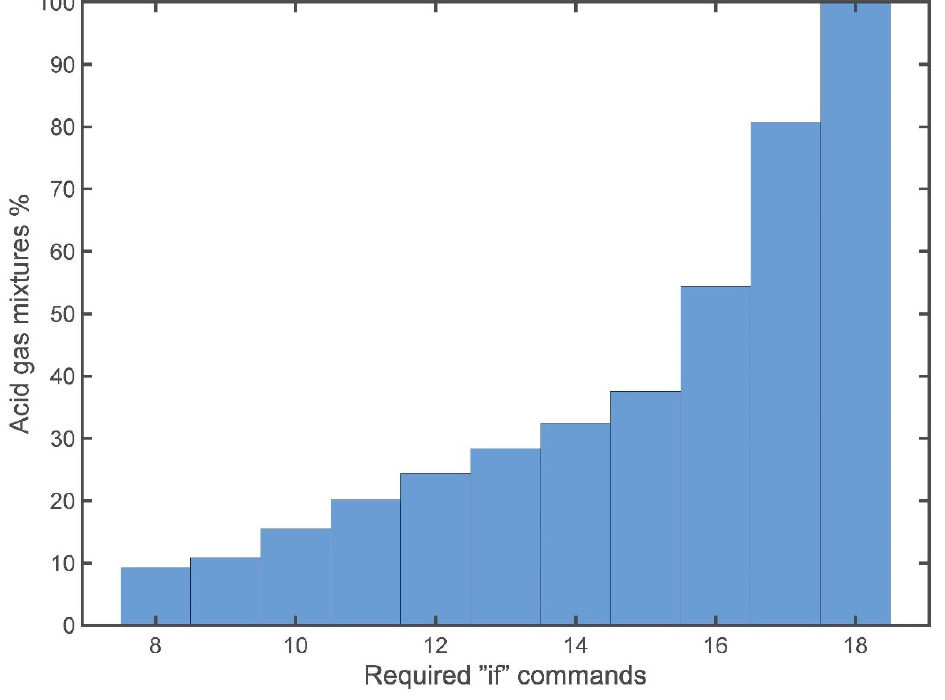
Figure 6. Cumulative number of “if” commands required to arrive to a definite answer.